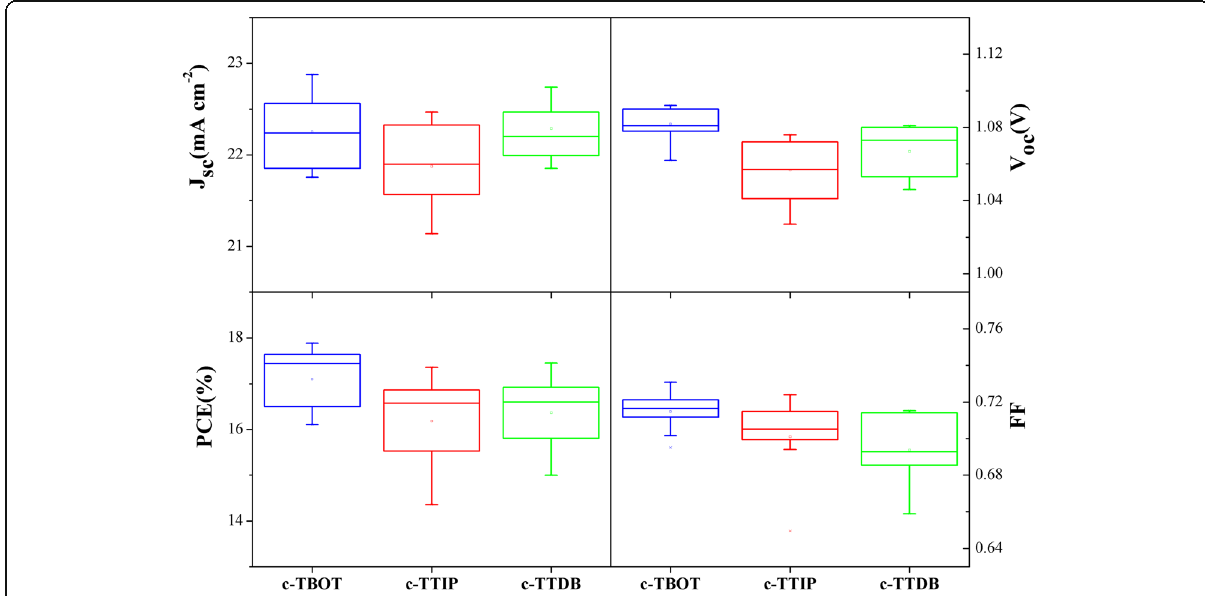
Fig. 3 Photovoltaic parameters of devices plotted as a function of different compact layers (i.e, J sc , V oc , FF, and